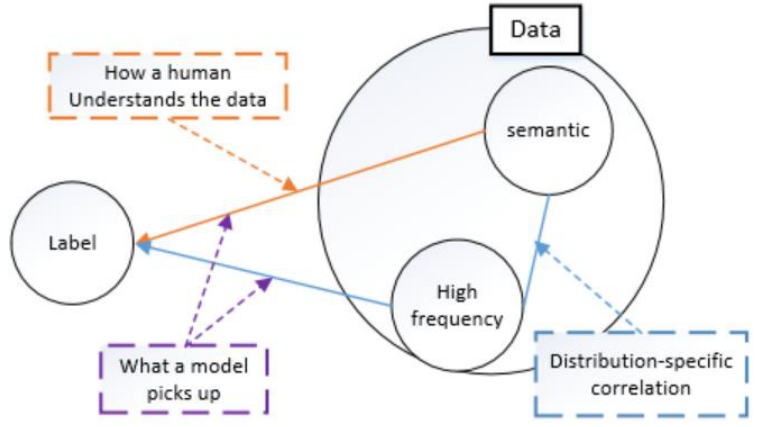
Figure 2. The difference between CNN and human understanding of the data.